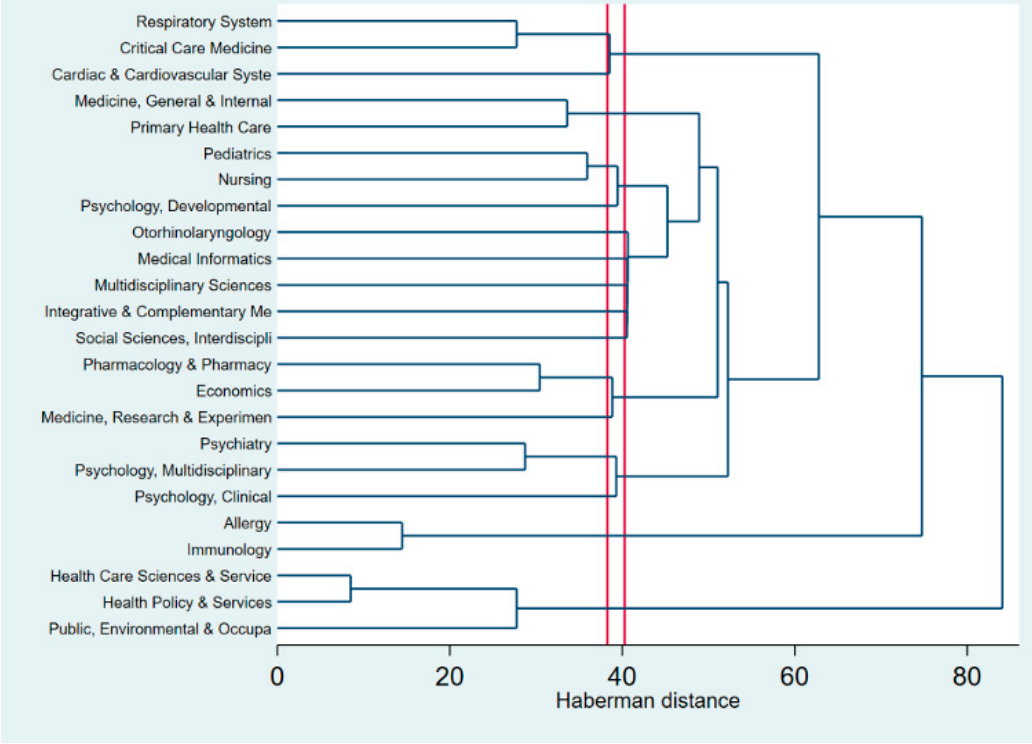
Figure 4. Dendrogram of coincidence of research areas using the Web of Science (WoS) lassifications.